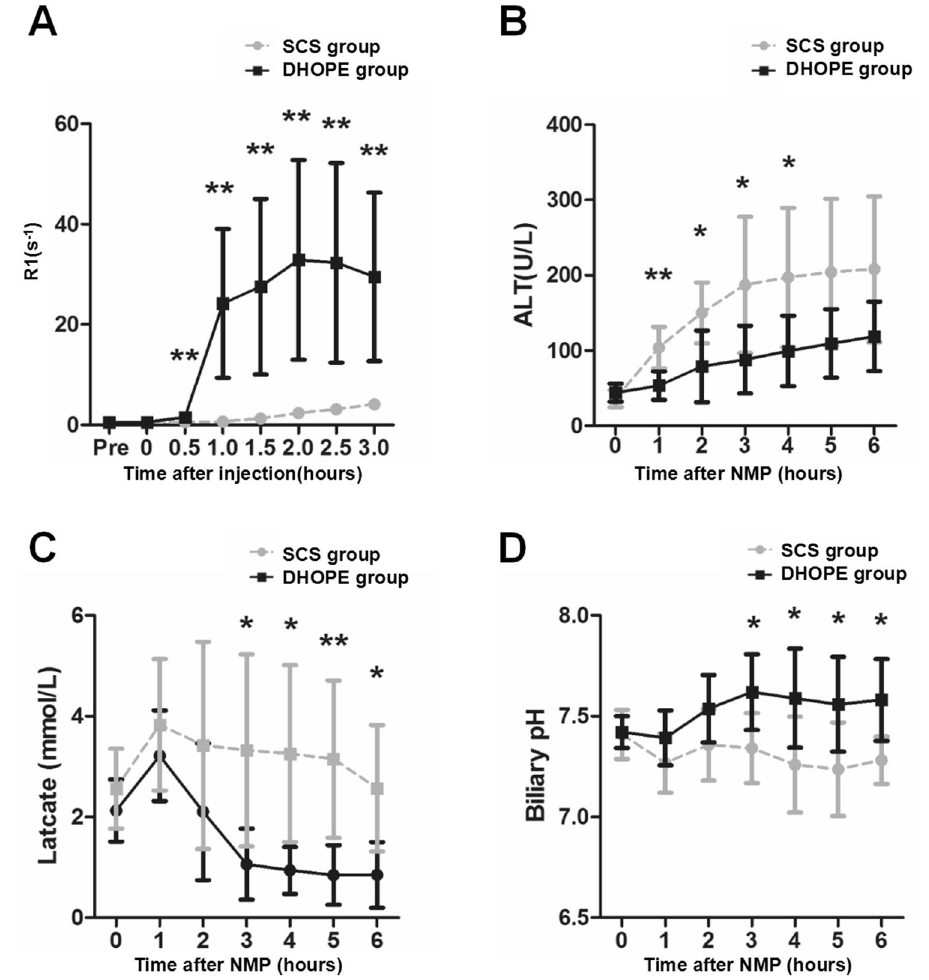
Figure 6. Evaluation of biliary R1, ALT and lactate levels, and biliary pH during NMP after 6 h of DHOPE or SCS treatments. ( A – E ) Analysis of biliary R1, ALT, perfusate lactate, and biliary pH during NMP following 6 h of DHOPE or SCS treatment at the indicated time points. Data represent mean ± SD. Two-way ANOVA was used for analysis the differences between two groups. DHOPE group vs. SCS group: * P < 0.05, ** P <